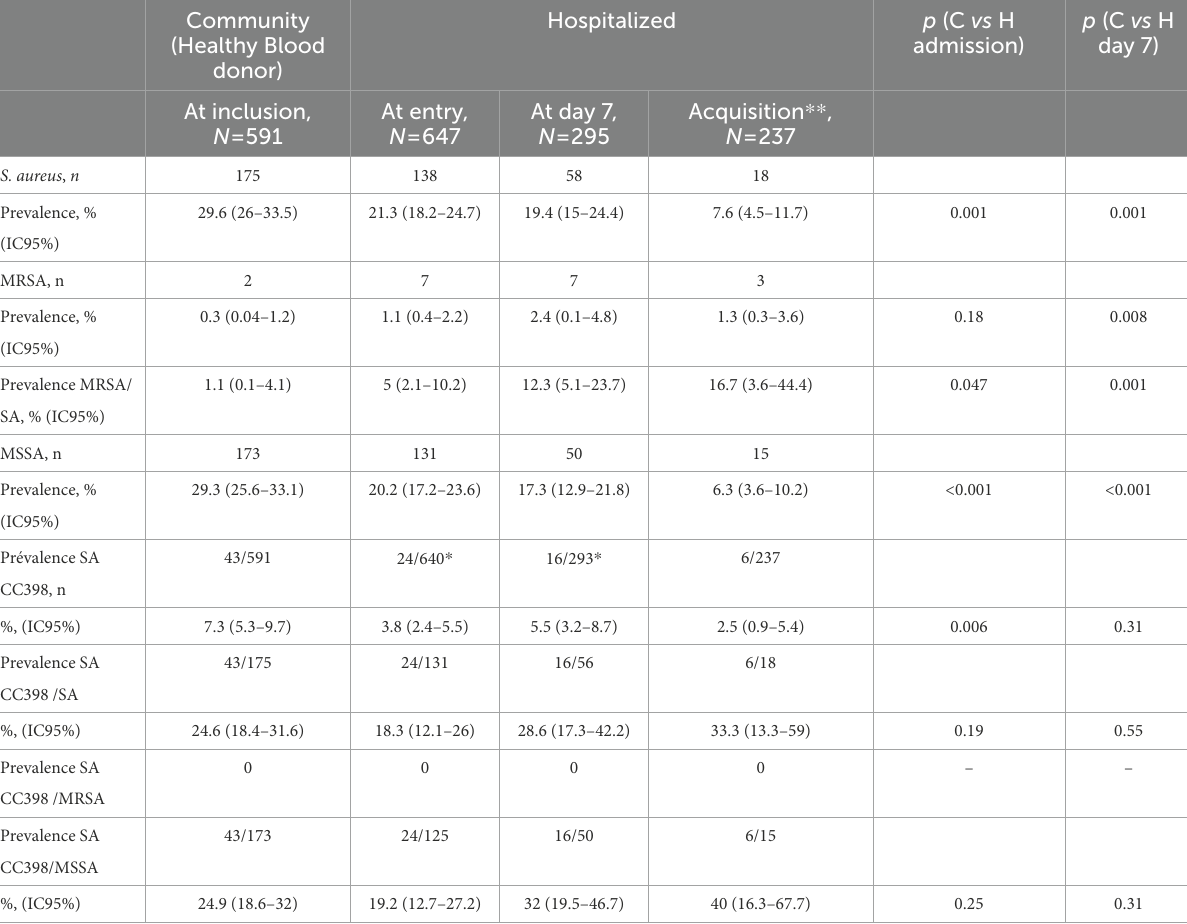
TABLE 1 Prevalence of nasal carriage of S. aureus and S. aureus CC398 in healthy blood donors and hospitalized